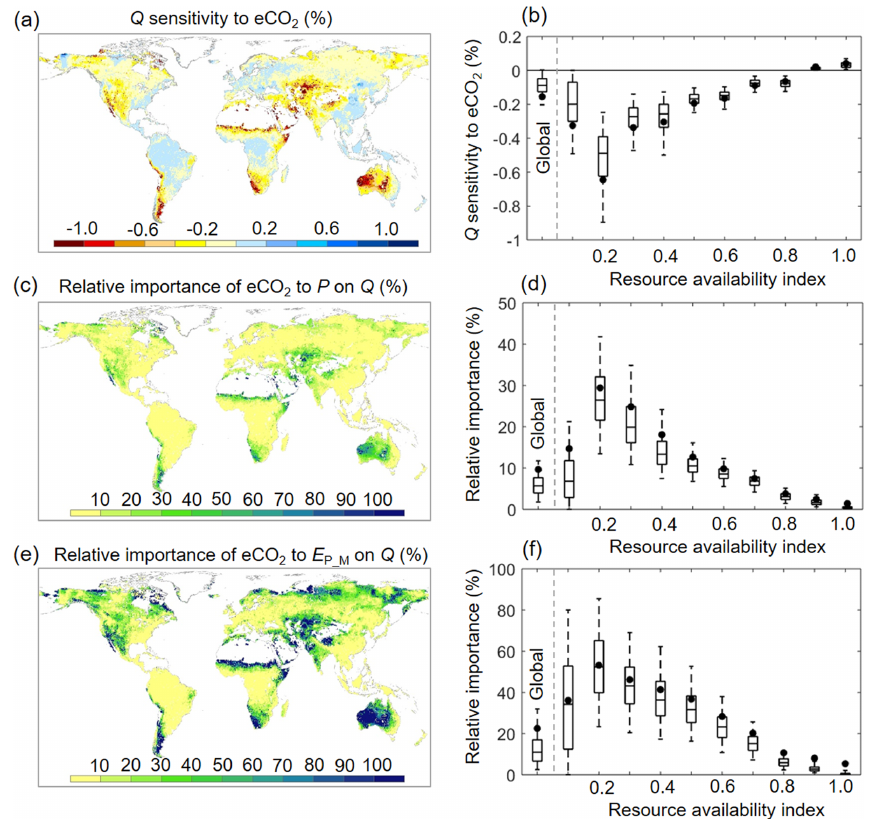
Figure 9. Sensitivity of Q to eCO 2 and its relative importance to P and E P _M across the globe. (a) Spatial distribution of Q sensitivity to eCO 2 (percent change in Q per 1% change in C a ). (b) Boxplot of Q sensitivity to eCO 2 for each resource availability index category. (c) Relative importance of eCO 2 to Q compared to changes in P on Q (percent change in Q per 1% change in C a compared to percent change in Q per 1% change in P ). (d) Boxplot of the relative importance of eCO 2 to Q compared to changes in P on Q for each resource availability category. (e) Relative importance of eCO 2 to Q compared to changes in E P _M on Q (percent change in Q per 1% change in C a compared to percent change in Q per 1% change in E P ). (f) Boxplot of the relative importance of eCO 2 to Q compared to changes in E P _M on Q for each resource availability category. In (b) , (d) , and (f) , the upper and lower box edges represent the quartile divisions, the inner horizontal line is the median, the dots indicate the mean value, and the dashed lines represent the 5th and 95th percentiles. The number of grid cells in each resource availability index category is provided in Fig.